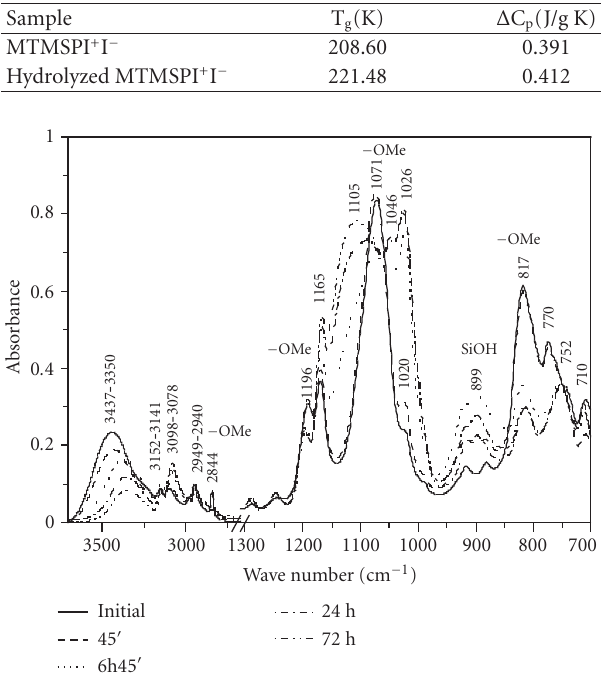
Figure 1: IR transmission spectra obtained by calculations from the measured ATR spectra. Intensities were normalized to the sample thickness of 1¯m.